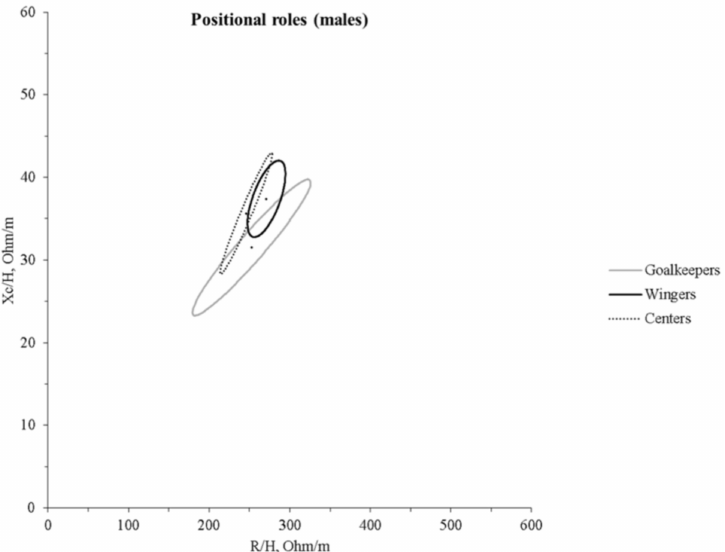
Figure 3. The 95% confidence ellipses for the mean impedance vectors of goalkeepers, winger, and centers. R/H, height-adjusted resistance; Xc/H, height-adjusted reactance. Compared to other athletic populations, our players significantly differ from both basketball [28] (T 2 = 11.2, D = 0.93, p = 0.006) and soccer [31] (T 2 = 86.6, D = 1.68, p < 0.0001) players (Figure